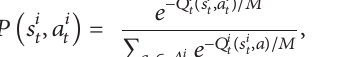
Figure 10: SU end-to-end delay for varying exploration probability 𝜀